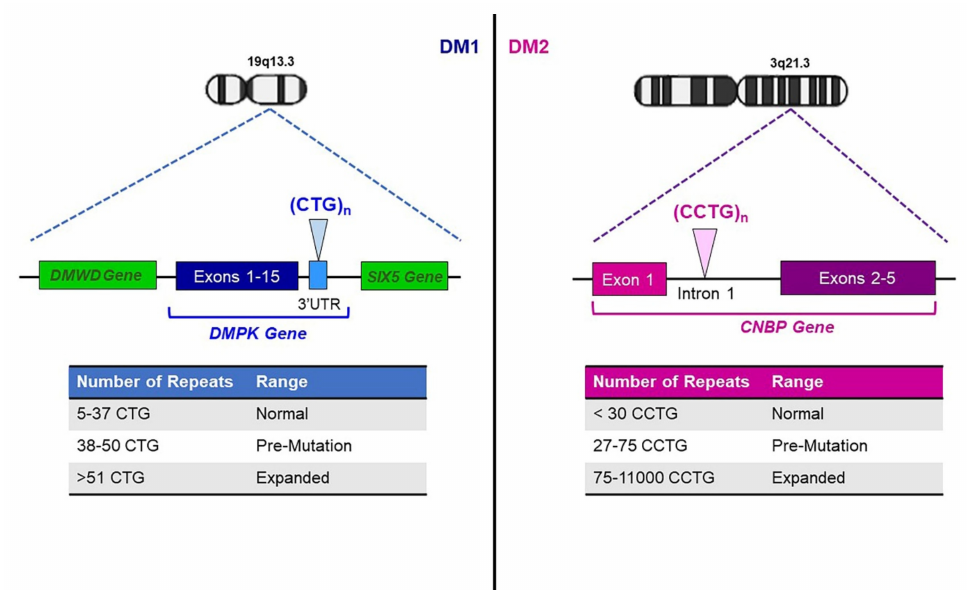
Figure 1. Genetics of myotonic dystrophies. DM1 is caused by a (CTG) n expansion in the 3 (cid:48) UTR of the DMPK gene on chromosome 19q13.3. Healthy individuals carry (CTG) 5-37 , DMPK -expanded alleles contain (CTG) ≥ 51 . DM2 is caused by a (CCTG) n expansion in the first intron of CNBP gene on chromosome 3q21.3. Healthy alleles contain (CCTG) <30 , whereas expanded alleles contain 75-11,000 copies of CCTG